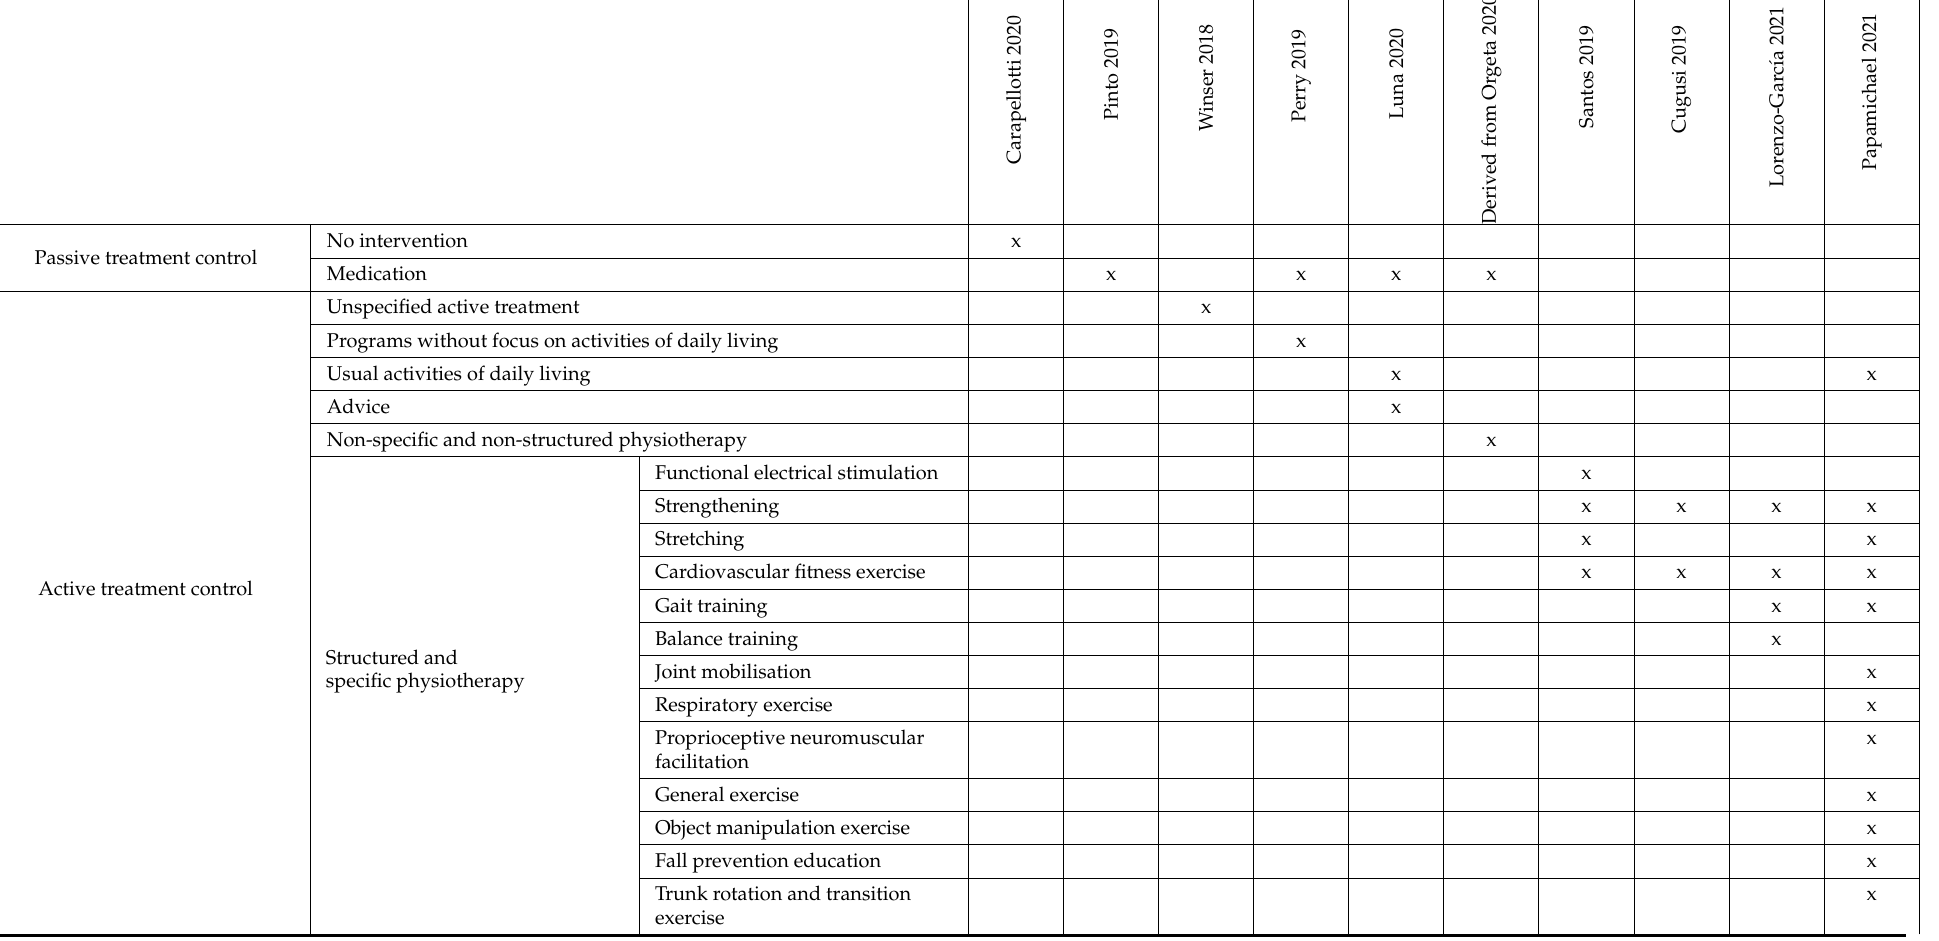
Table 1. Definition of usual, traditional, or conventional care in the reviewed